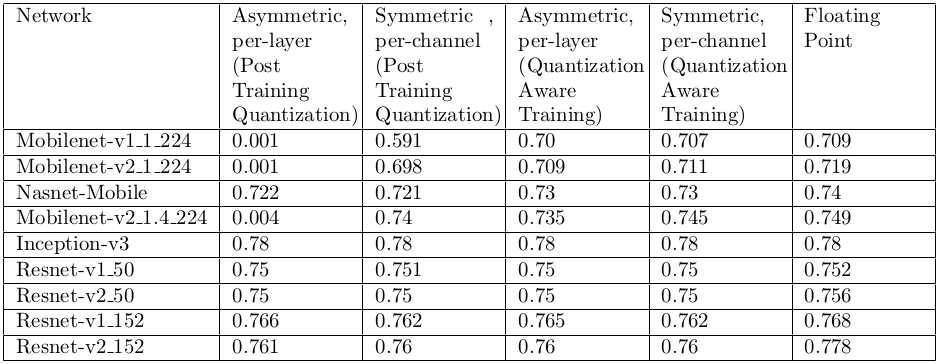
Table from the paper: Quantizing deep convolutional networks for efficient inference: A whitepaper
Table text:
Network
Asymmetric,
per-layer
(Post
Training
Quantization)
Symmetric ,
per-channel
(Post
Training
Quantization)
Asymmetric,
per-layer
(Quantization
Aware
Training)
Symmetric,
per-channel
(Quantization
Aware
Training)
Floating
Point
Mobilenet-v11224
0.001
0.591
0.70
0.707
0.709
Mobilenet-v21224
0.001
0.698
0.709
0.711
0.719
Nasnet-Mobile
0.722
0.721
0.73
0.73
0.74
Mobilenet-v21.4224
0.004
0.74
0.735
0.745
0.749
Inception-v3
0.78
0.78
0.78
0.78
0.78
Resnet-v150
0.75
0.751
0.75
0.75
0.752
Resnet-v250
0.75
0.75
0.75
0.75
0.756
Resnet-v1152
0.766
0.762
0.765
0.762
0.768
Resnet-v2152
0.761
0.76
0.76
0.76
0.778